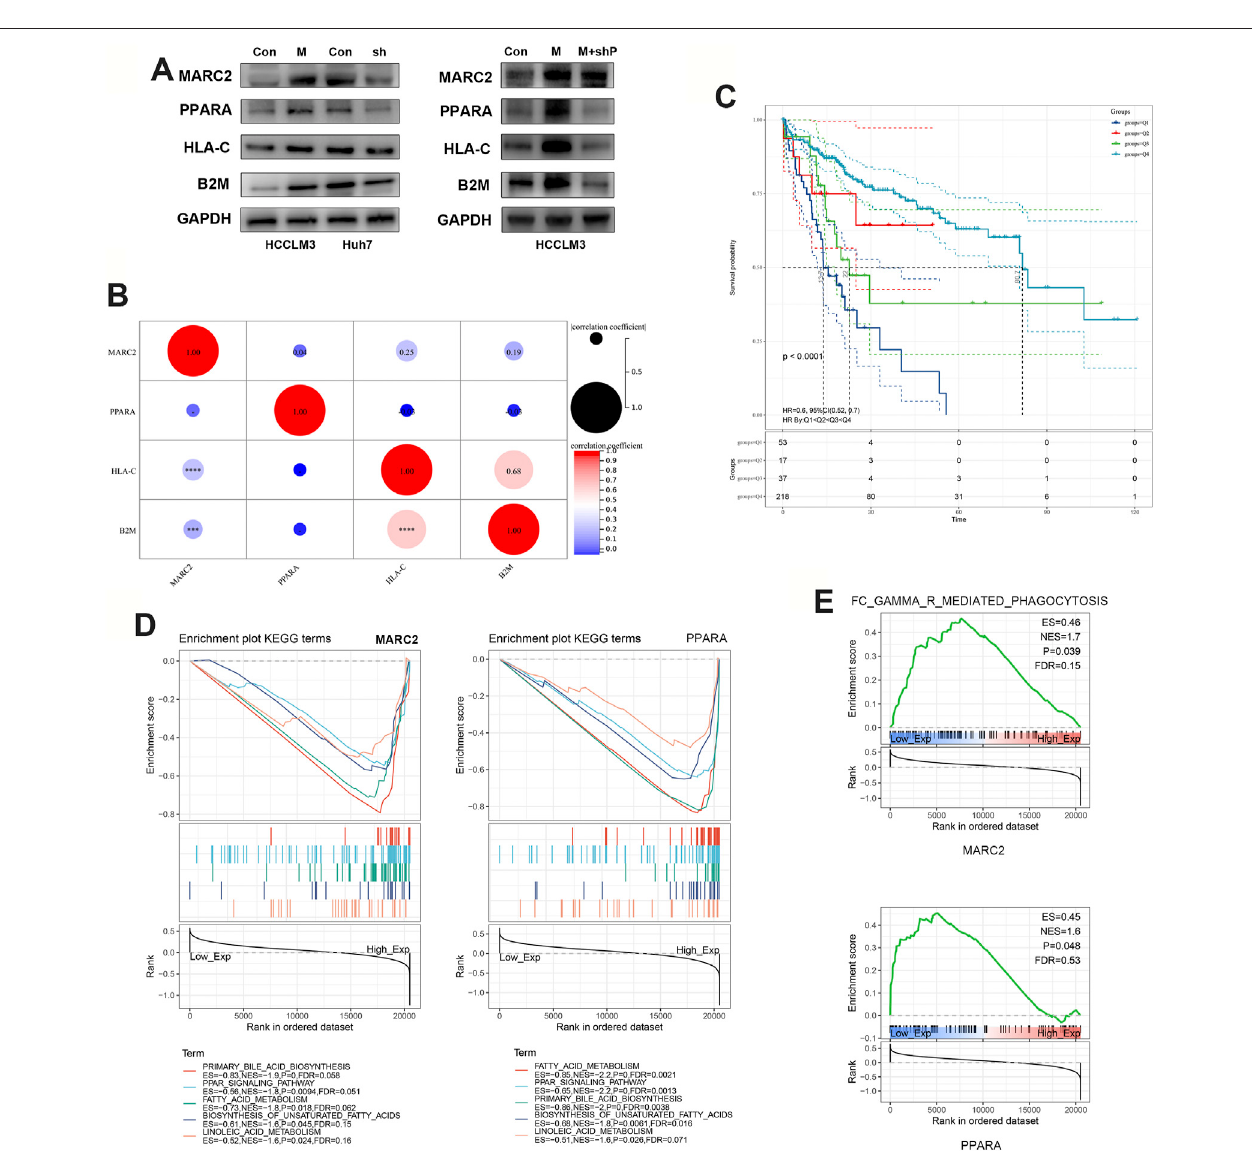
FIGURE 4 | MARC2 facilitated the tumor antigen presentation via PPARA signaling pathway. (A) Western blot was used to measure the protein expression of MARC2, PPARA, HLA-C, and B2M in the indicated cell lines. Control: HCCLM3 transfected with control plasmid; MARC2: HCCLM3 transfected with MARC2 overexpression plasmid; sh: HCCLM3 transfected with PPARA knockdown plasmid. (B) The correlation between MARC2 and PPARA, HLA-C and B2M. (C) The prognosticvalueofthecombinationofMARC2andCD8+TcellwasdeterminedbyKaplan-Meiercurves.Q1:MARC2lowandCD8+Tcelllow;Q2:MARC2lowand CD8+Tcellhigh;Q3:MARC2highandCD8+Tcelllow;Q4:MARC2highandCD8+Tcellhigh. (D – E) Signalingpathwaysrelated withMARC2andPPARA.ThePearson correlation coef fi cient was used to determine the correlation. ***p < 0.001; ***p <